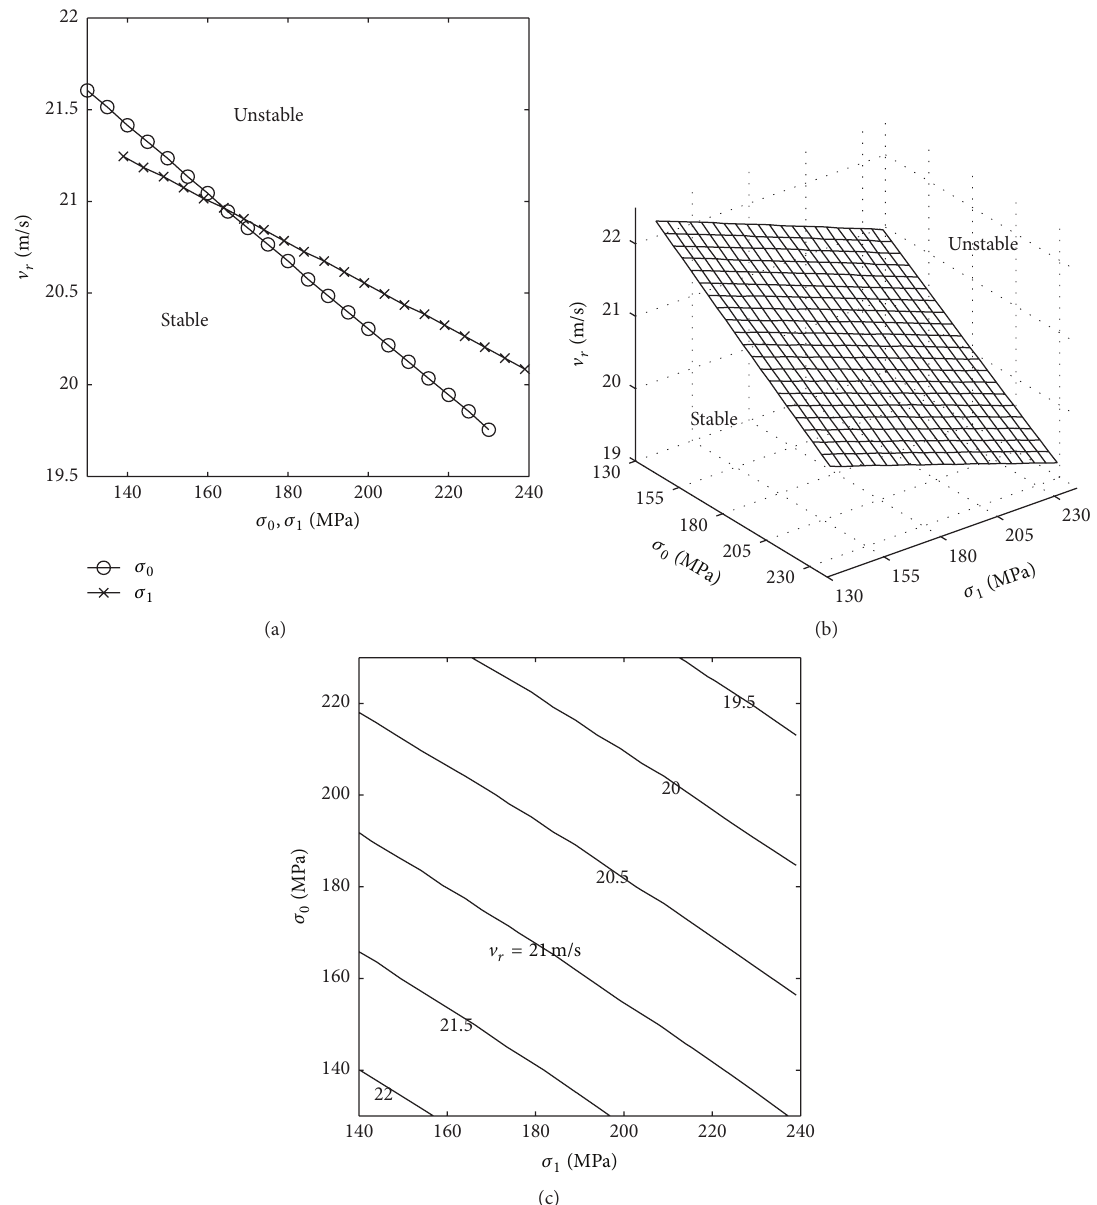
Figure 12: Influences of tensions at entry and exit on system